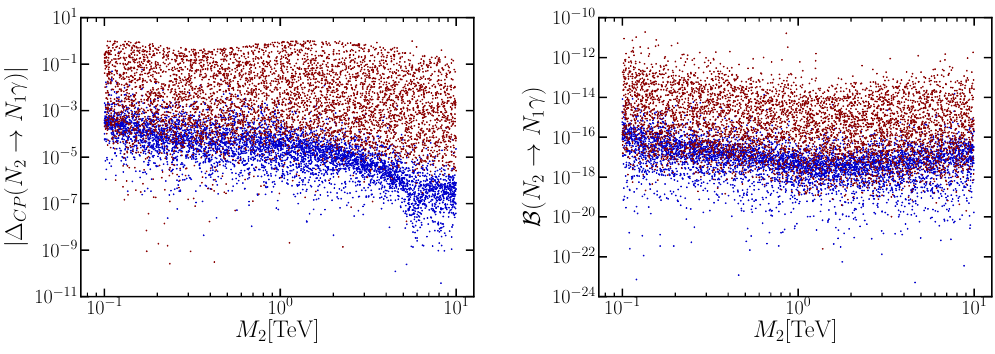
Figure 3 . The CP asymmetry parameter ∆ CP (left) and branching ratio (right) scanned in the region M 2 in [0 . 1 , 10] TeV and the ratio M 1 /M 2 in [0 . 1 , 1) , where both masses are scanned in the logarithmic scale. The red region refers to ω = [0 , 2 π ] + i [ − 5 , 5] while the blue region is the smaller ω = [0 , 2 π ] . All oscillation parameters are scanned in the 3 σ ranges, ω = [0 , 2 π ] and ζ = +1 are used. The scan performed for the ζ = − 1 branch gives the same distribution and is thus